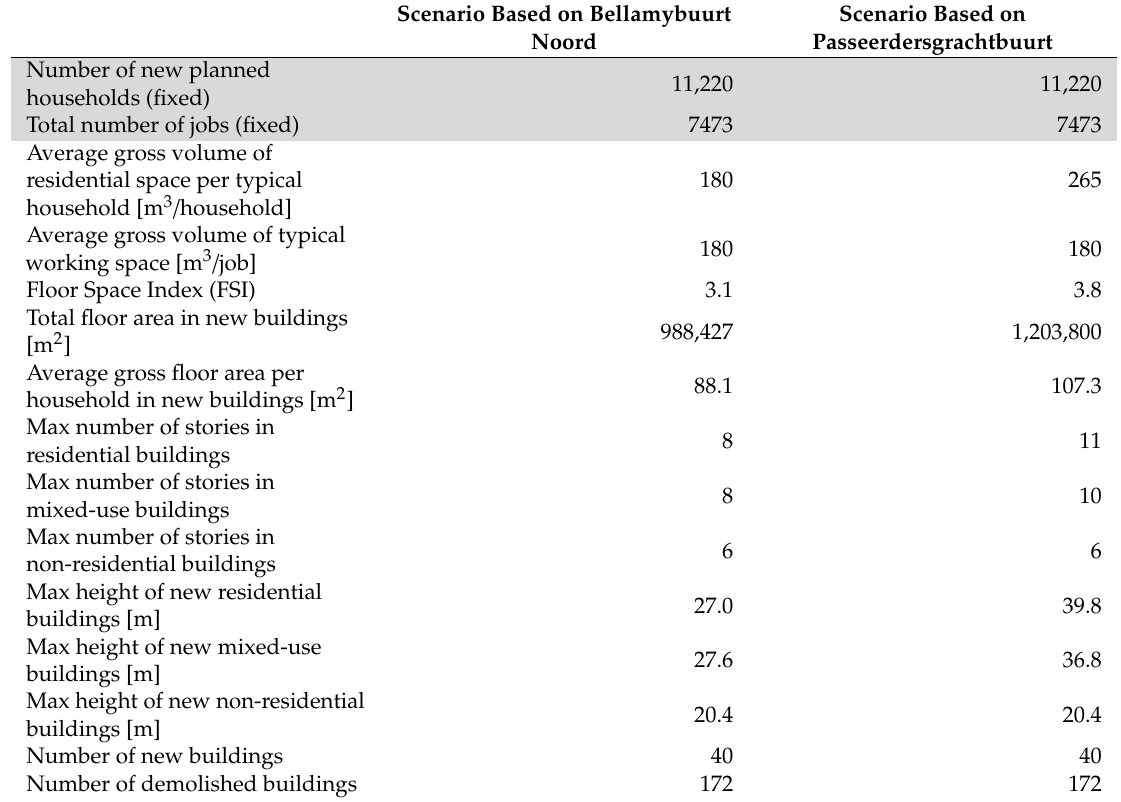
Table 9. Comparison of two scenarios for “Sloterdijk